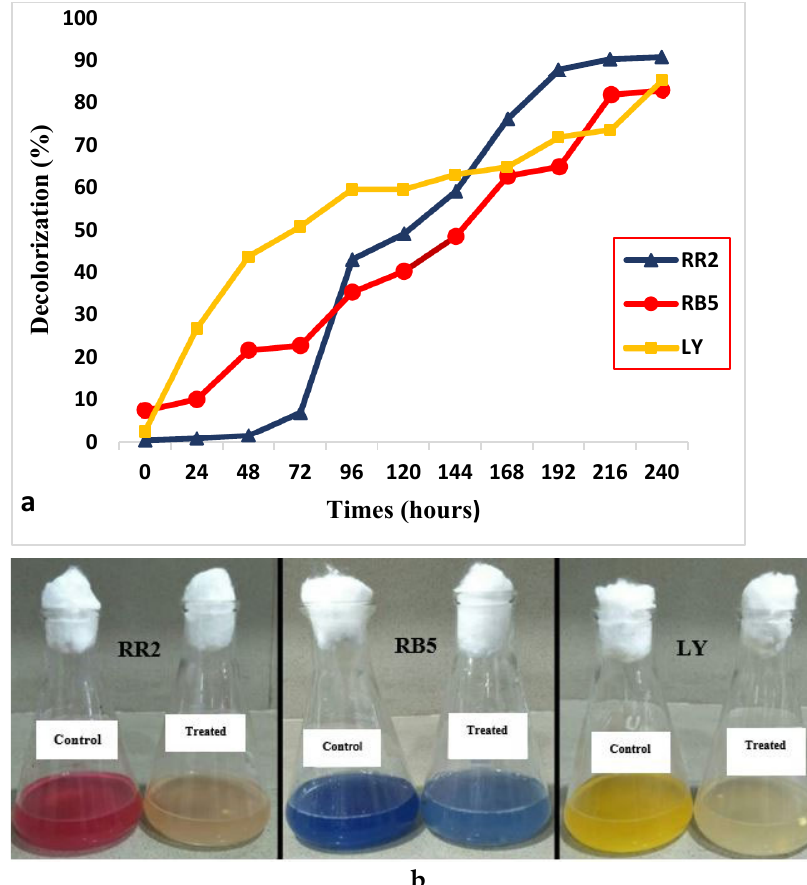
Figure 4. Decolorization/degradation of different dyes by P. caudatum UR03 in 100 mL of culture medium inoculated with 10 ul of azo dyes over a period of 10 days. ( a ) Showed the decolorization profile of different dyes monitored after every 24 h for 10 days. ( b ) Showed the azo dye degradation as indicated by decolorization in the flasks.